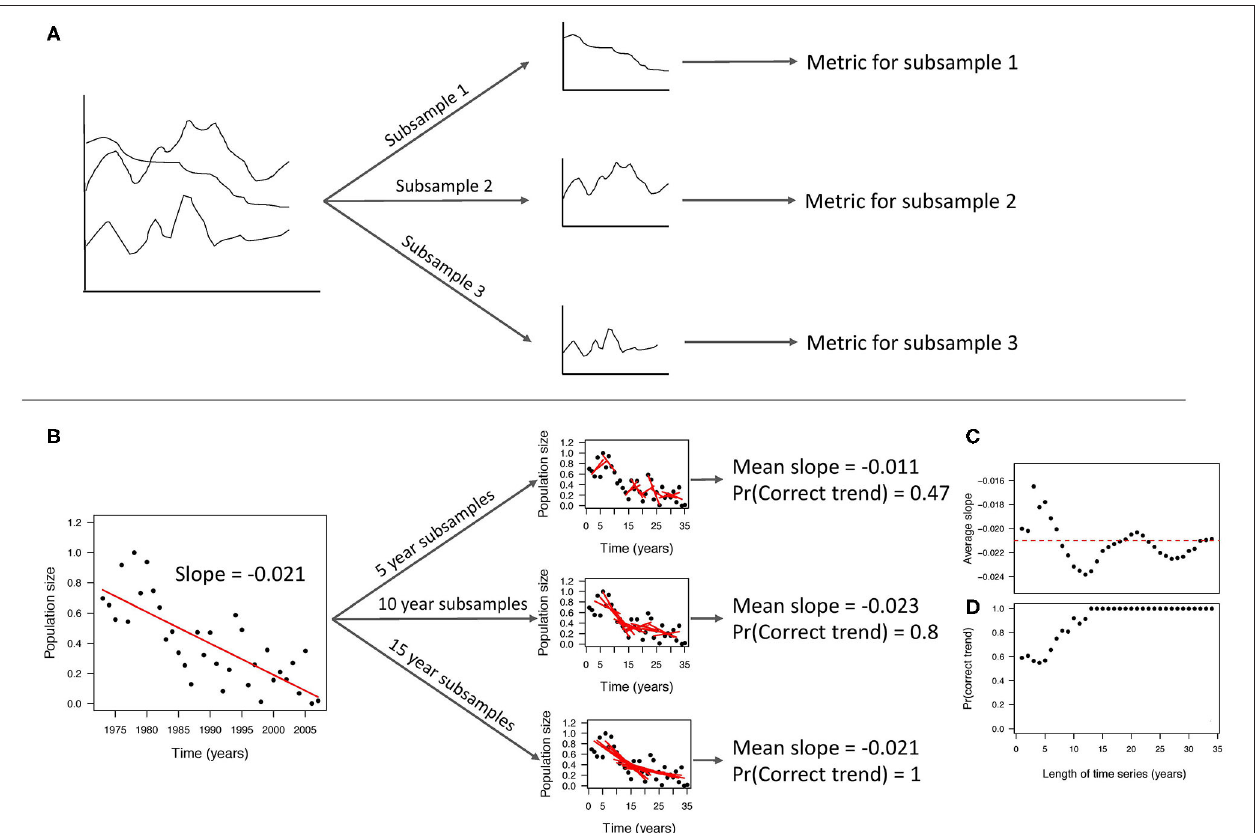
FIGURE 1 | (A) The general process of non-random resampling of past data from left to right (i.e., sequentially, starting with data from farthest into the past) includes: dividing data into non-random subsamples (based on the question of interest), calculating metrics on those subsamples, and comparing the subsample metrics to the combined (i.e. “true metric”) dataset, (B) same process as Table (a), but for specific example of examining the minimum number of years required to detect long-term population trends (White, 2019). The pair of figures on the bottom right show how the (C) average slope and the (D) probability of correcting identifying a trend change with the number of years